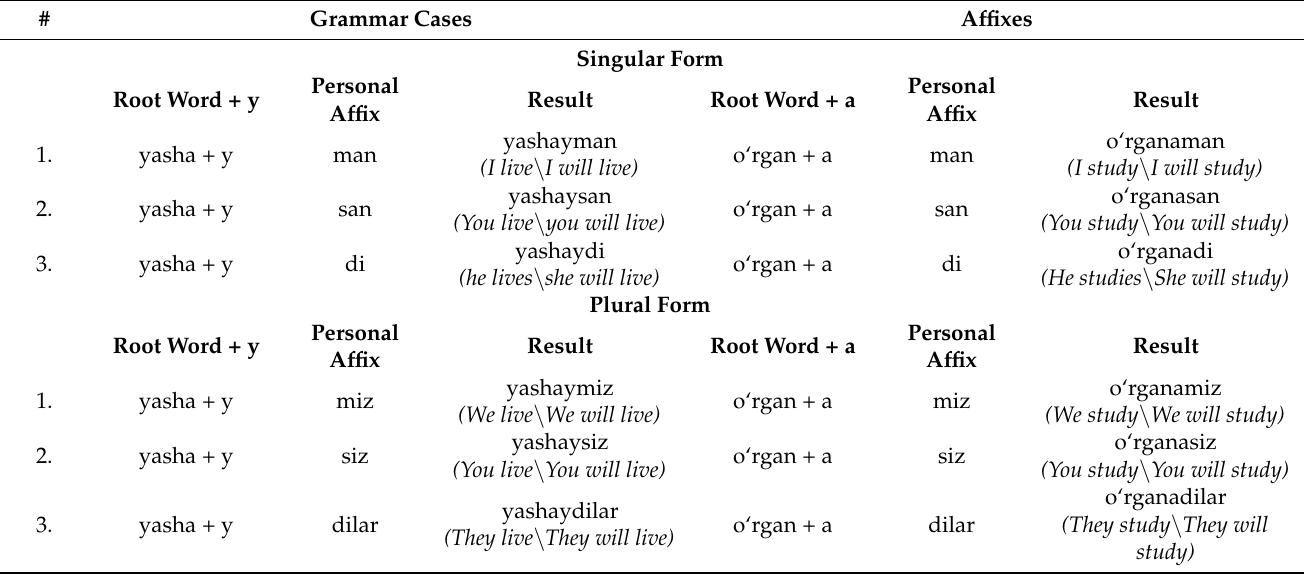
Table 7. Example of grammar rules of verb construction in the present–future tense.